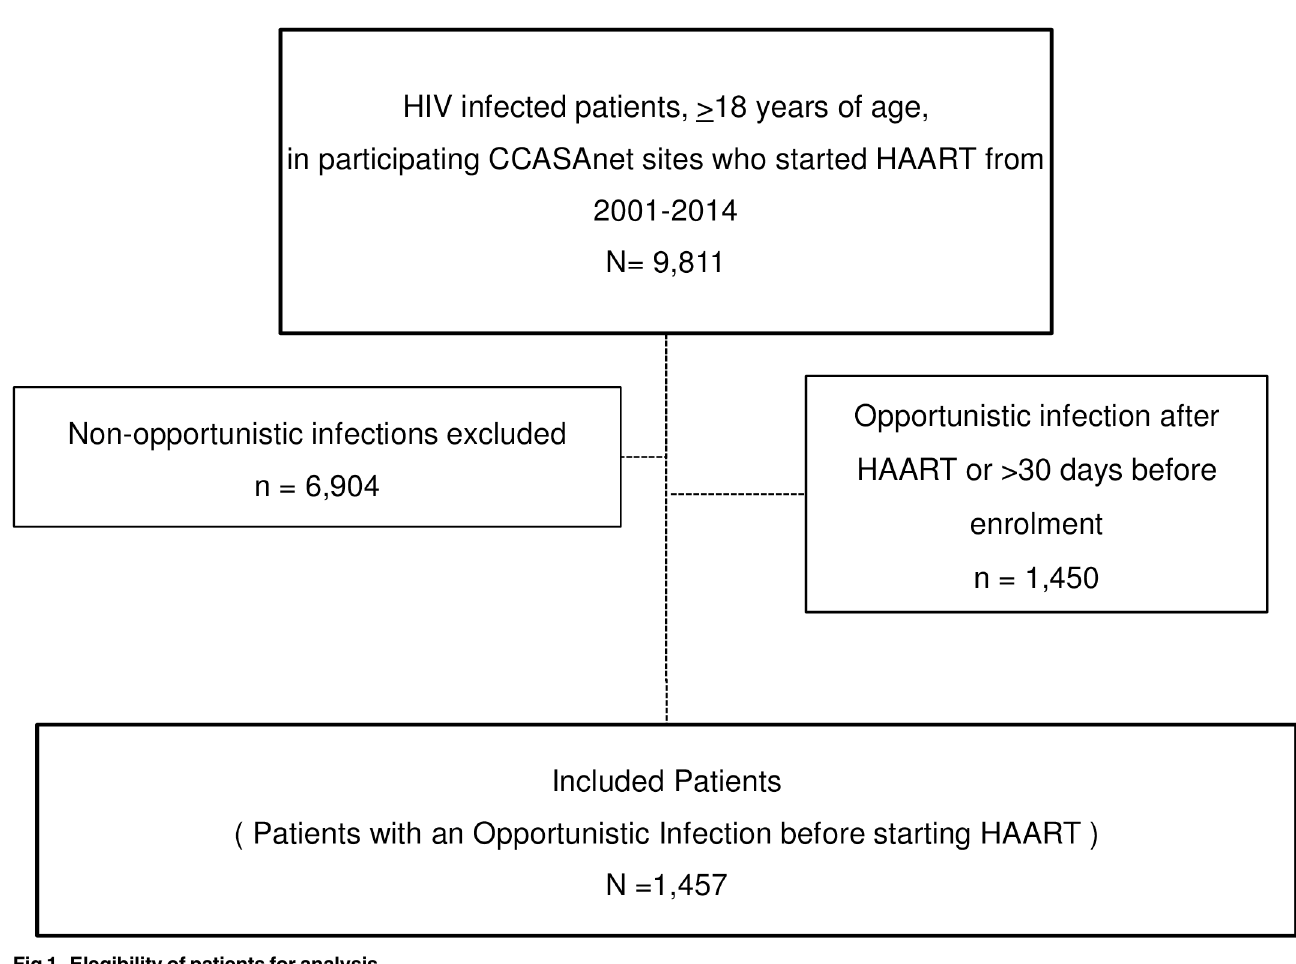
Fig 1. Elegibility of patients for